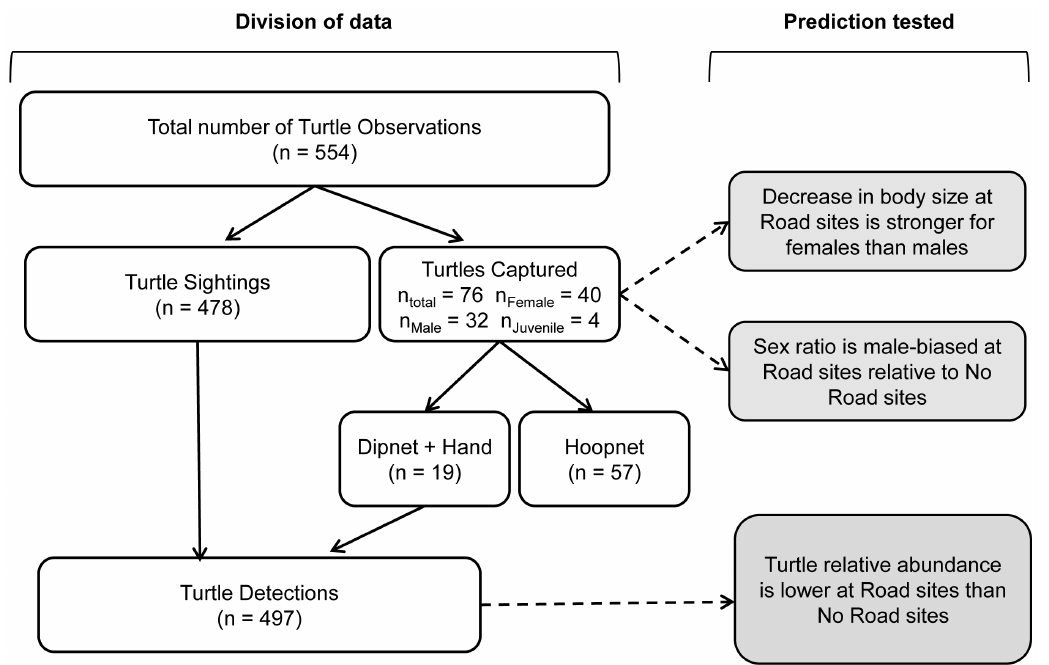
Figure 2. The division of data into groupings used for analyses. Data categories are shown in white boxes with solid black arrows showing which data are included in each of the categories. Predictions tested are shown in grey boxes with dashed arrows indicating the data category (in these cases the response variable) used in each.